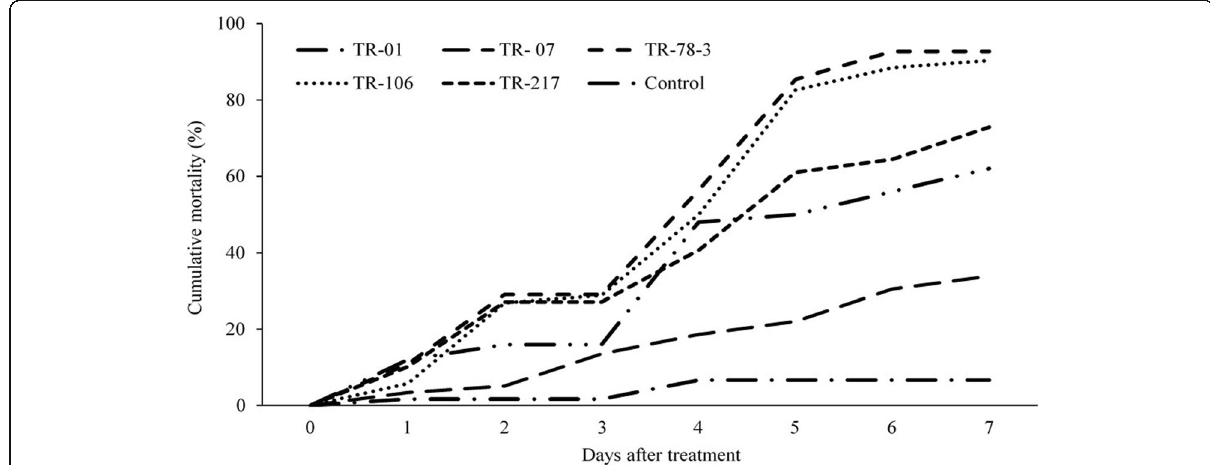
Fig. 1 Mortality rate of Sitophilus oryzae treated with entomopathogenic fungi at 20